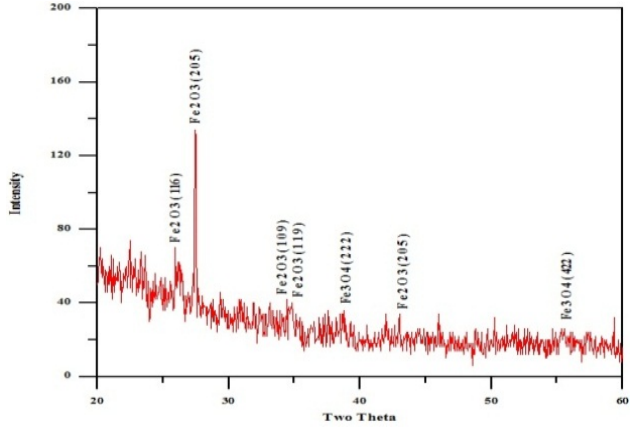
Figure 6. XRD spectrum of nanoparticles synthesis